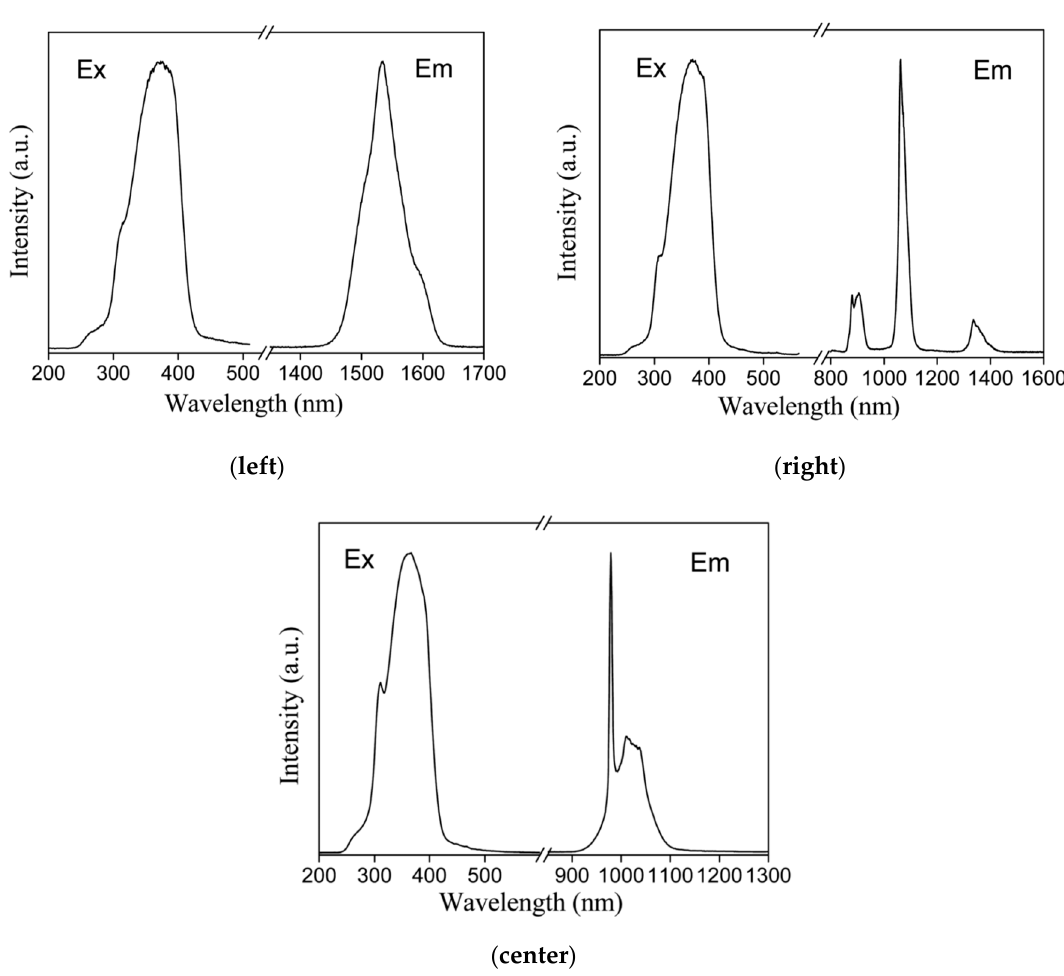
Figure 6. Normalized excitation and emission spectra of the Er 3+ ( left ), Nd 3+ ( center ) and Yb 3+ ( right )